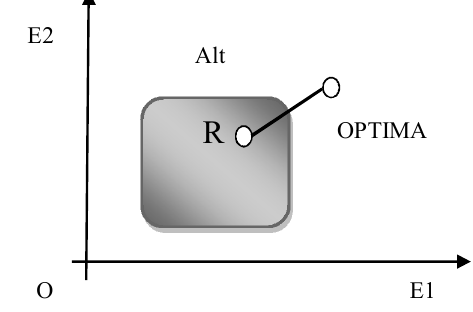
Fig 2. Solution Function in 2 - Dimensional